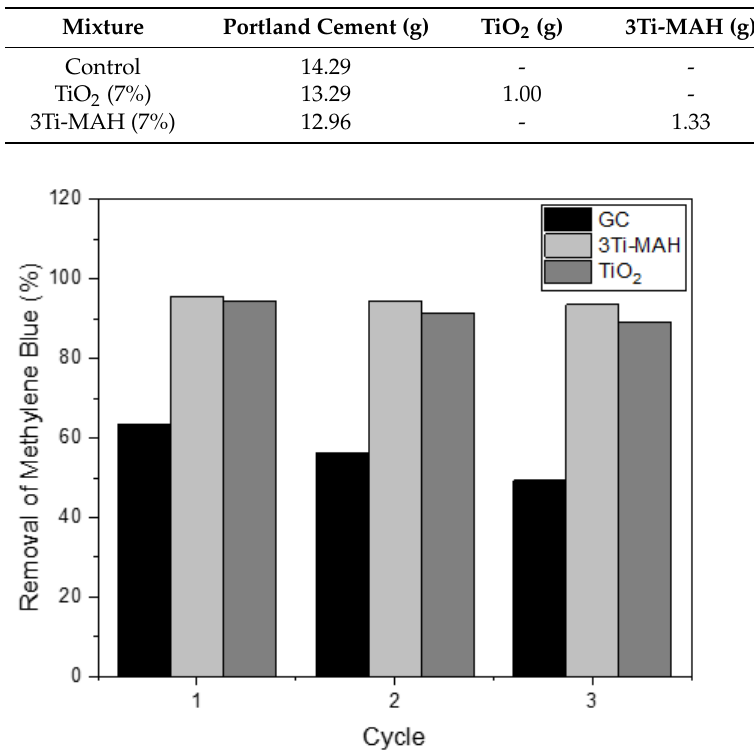
Table 1. Mixture designs’ initial testing.